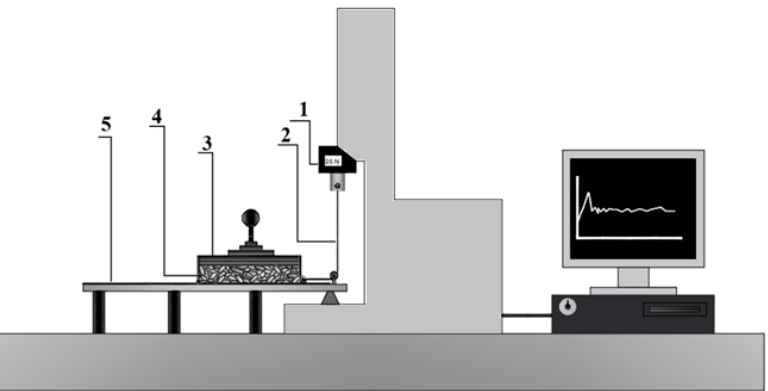
Figure 2. Diagram of the testing machine: 1. Load cell, 2. Cable, 3. Load, 4. Bottomless box, 5. Steel sheet.